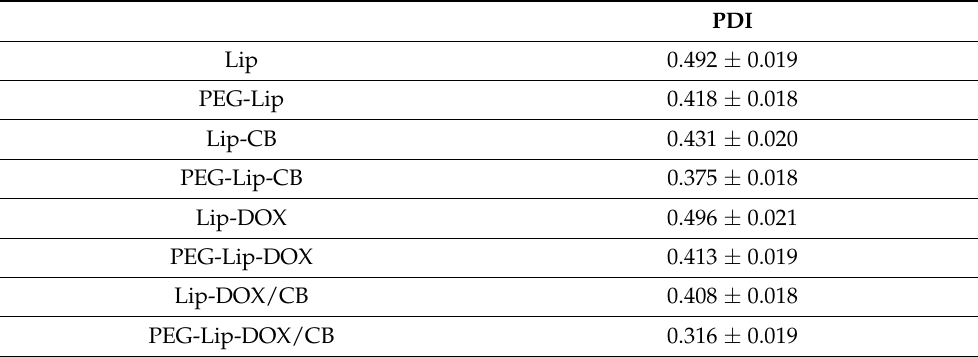
Figure 1. Scanning electron microscopy (SEM) of Lip, Lip-DOX, Lip-CB, Lip-DOX/CB, PEG-Lip, PEG-Lip-DOX, PEG-Lip-CB, and PEG-Lip-DOX/CB. Table 3. PDI values of the nanoparticles after freeze-drying obtained by the Zetasizer